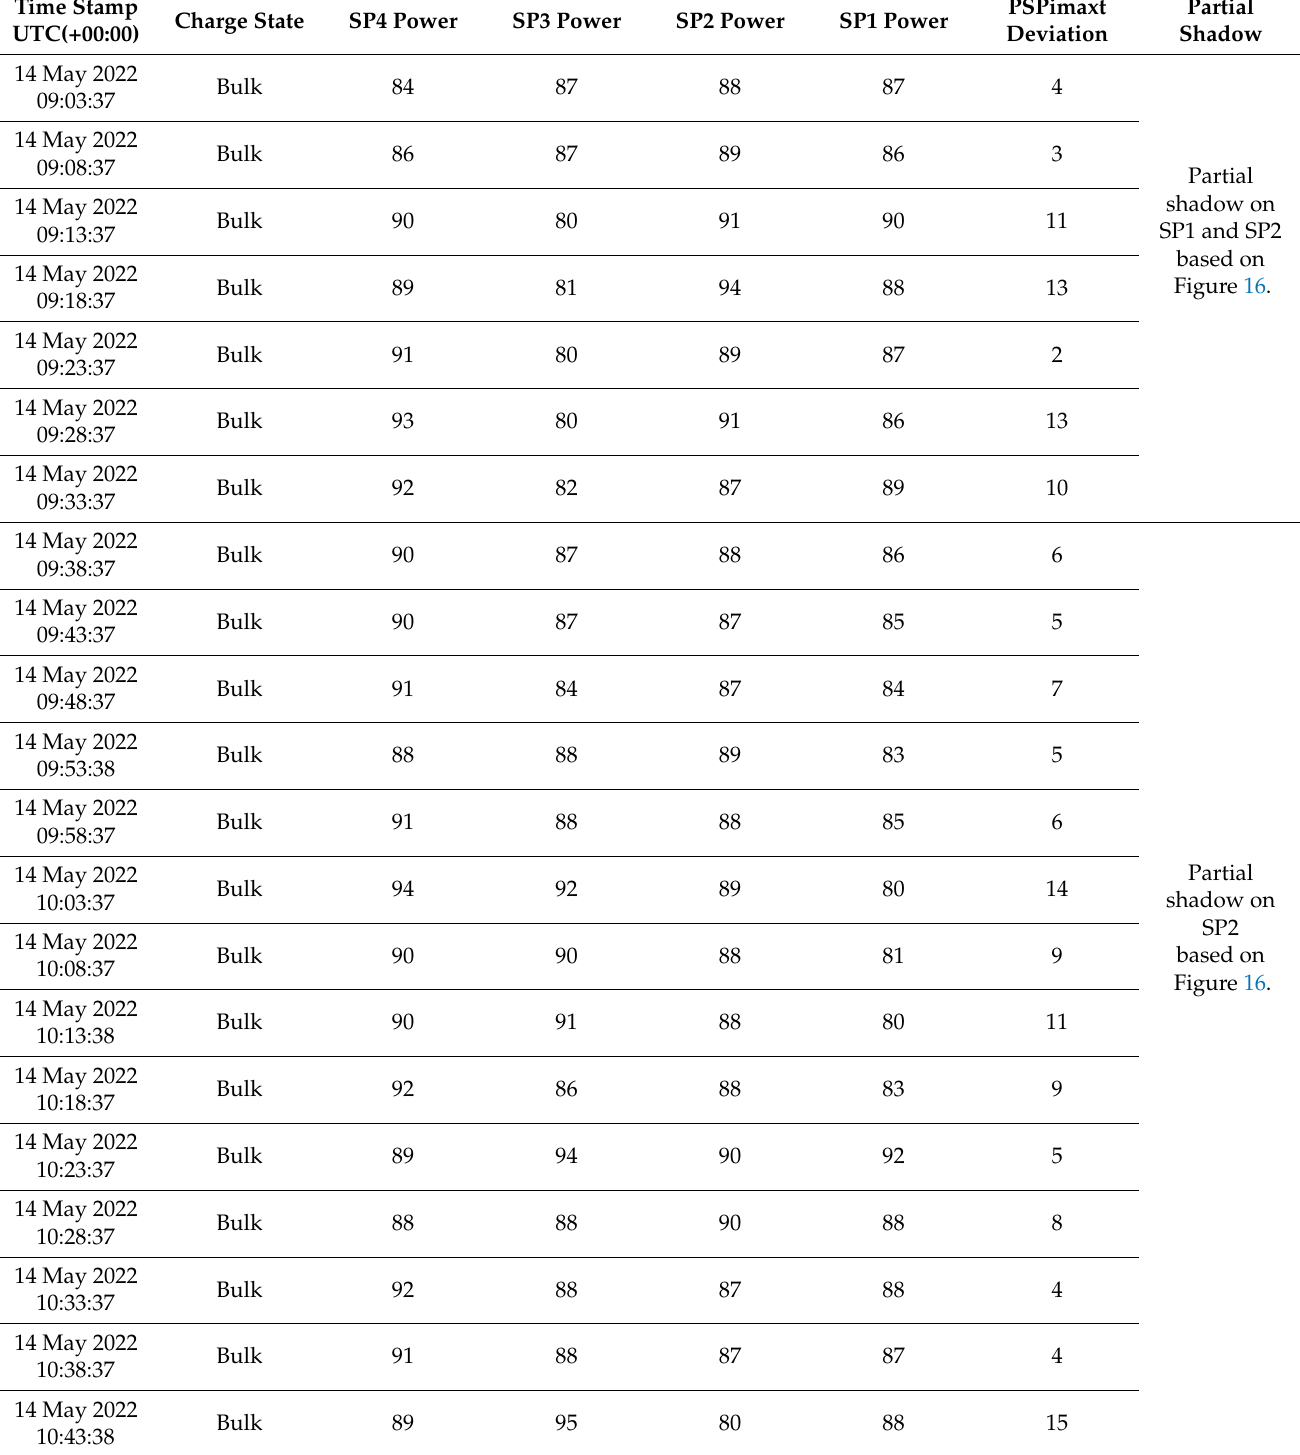
Table A2. SP quantitative power values and deviation registered the 14 May 2022 from 09:03:37 to 17:13:38